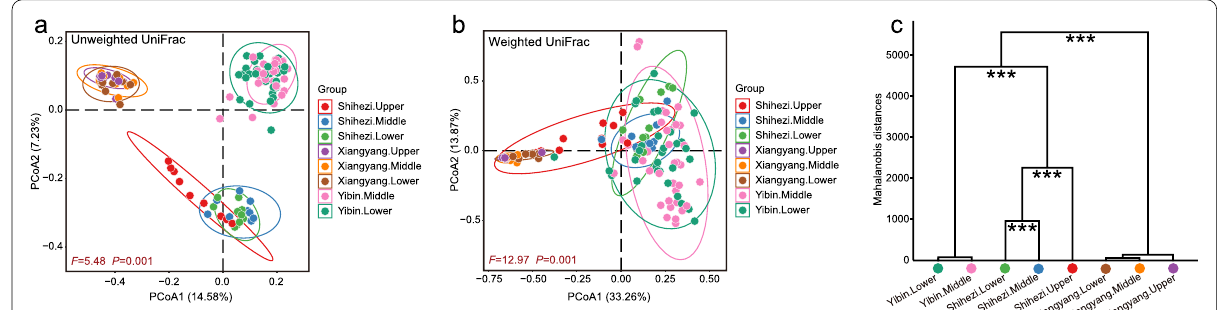
Fig. 3 Effects of distillery and depth on bacterial community composition. a , b represent PCoA score plots based on unweighted and weighted UniFrac distances, respectively; c CAP performed using the first 106 principal components, calculated from weighted UniFrac distances. The mahalanobis distances of bacterial communities generated by CAP were used for cluster analysis. Significant differences are illustrated with *** P < 0.001